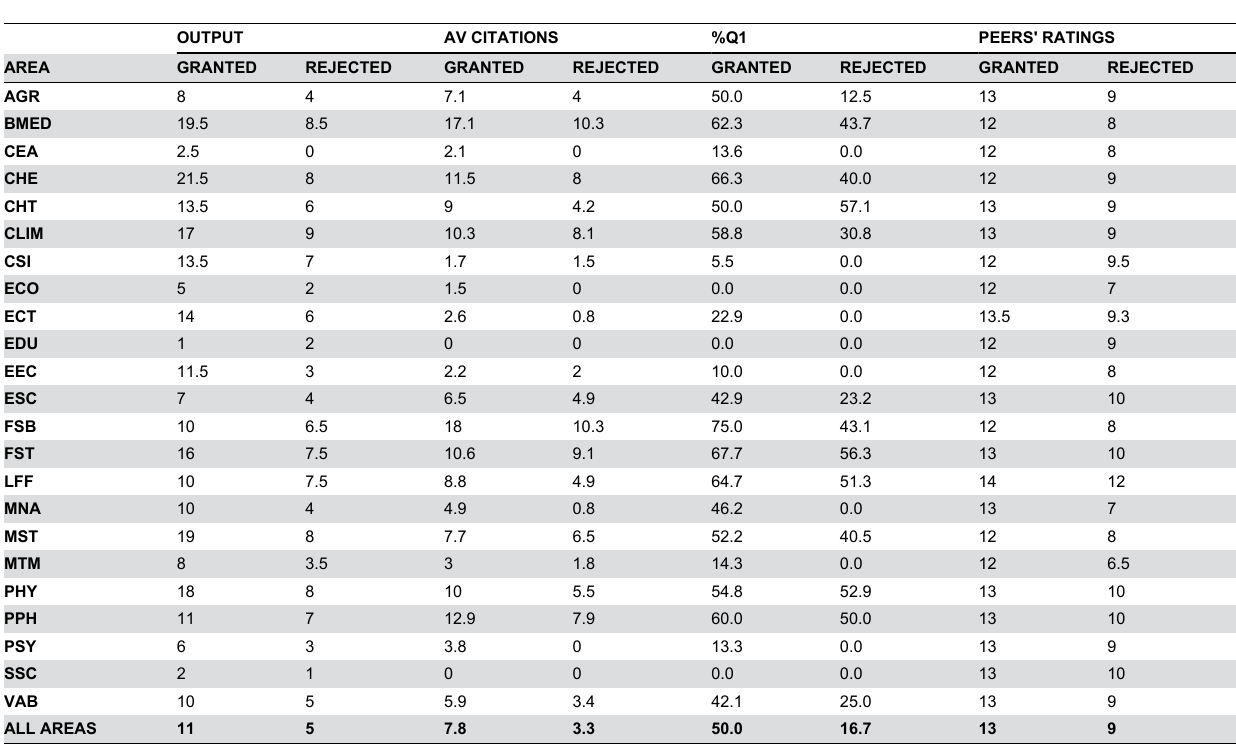
Table 5. Median values for PIs’ output, citations, Q1 publications and ratings indicators per